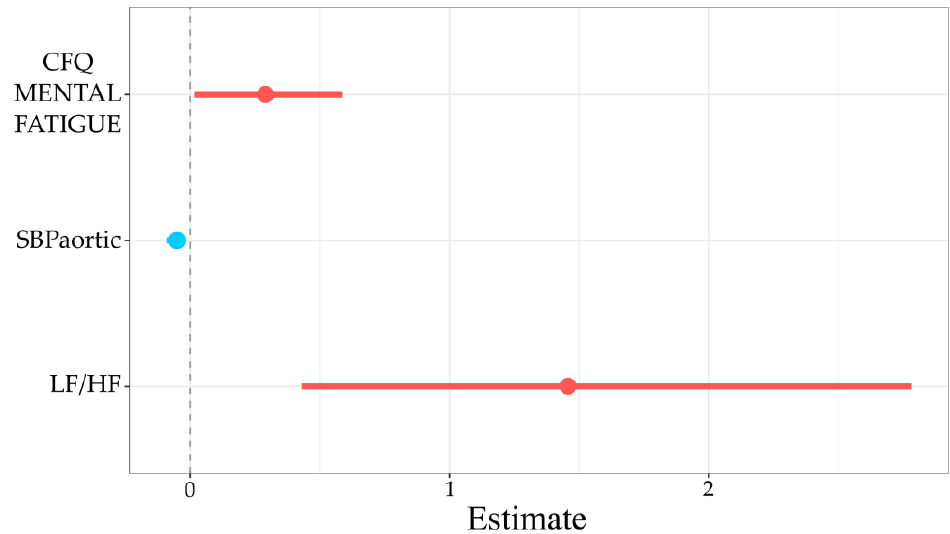
Figure 2. Logistic regression estimates predicting PEM presence. The horizontal axis refers to the odds ratio. Dots denote parameter estimates, while the horizontal lines through the dots denote 95% confidence intervals of the estimates.